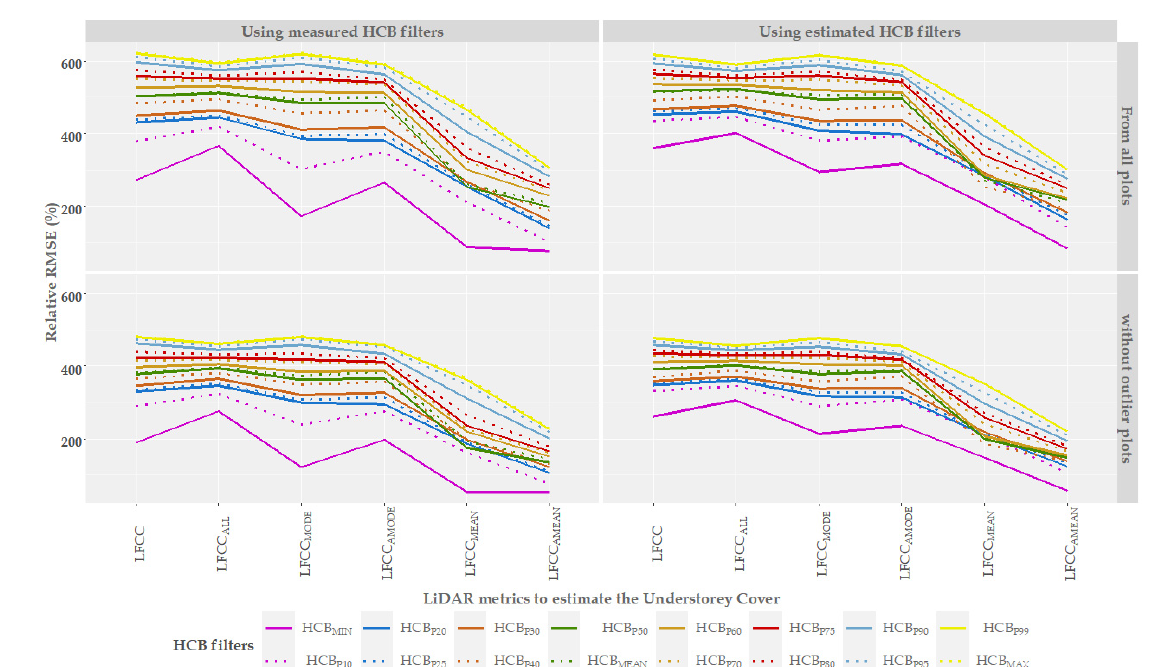
Figure 5 . Results of estimated UC: relative RMSE (%) (y axis) for HCB models (filters applied) and for each metric appraised (x axis) using all plots and a sample without outlier plots (rows in facet grid figure) and measured/estimated HCB models (columns in facet grid figure). The complete set of metrics in UC evaluation and their errors are included in Supplementary Materials—Table S2.